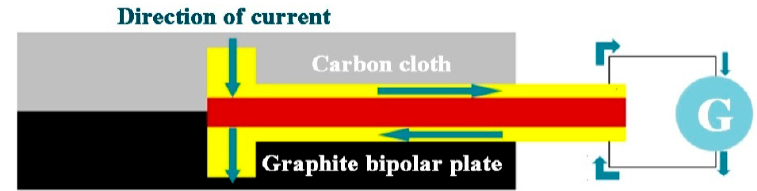
Figure 3. Schematic diagram of sensing principle of micro current sensor.